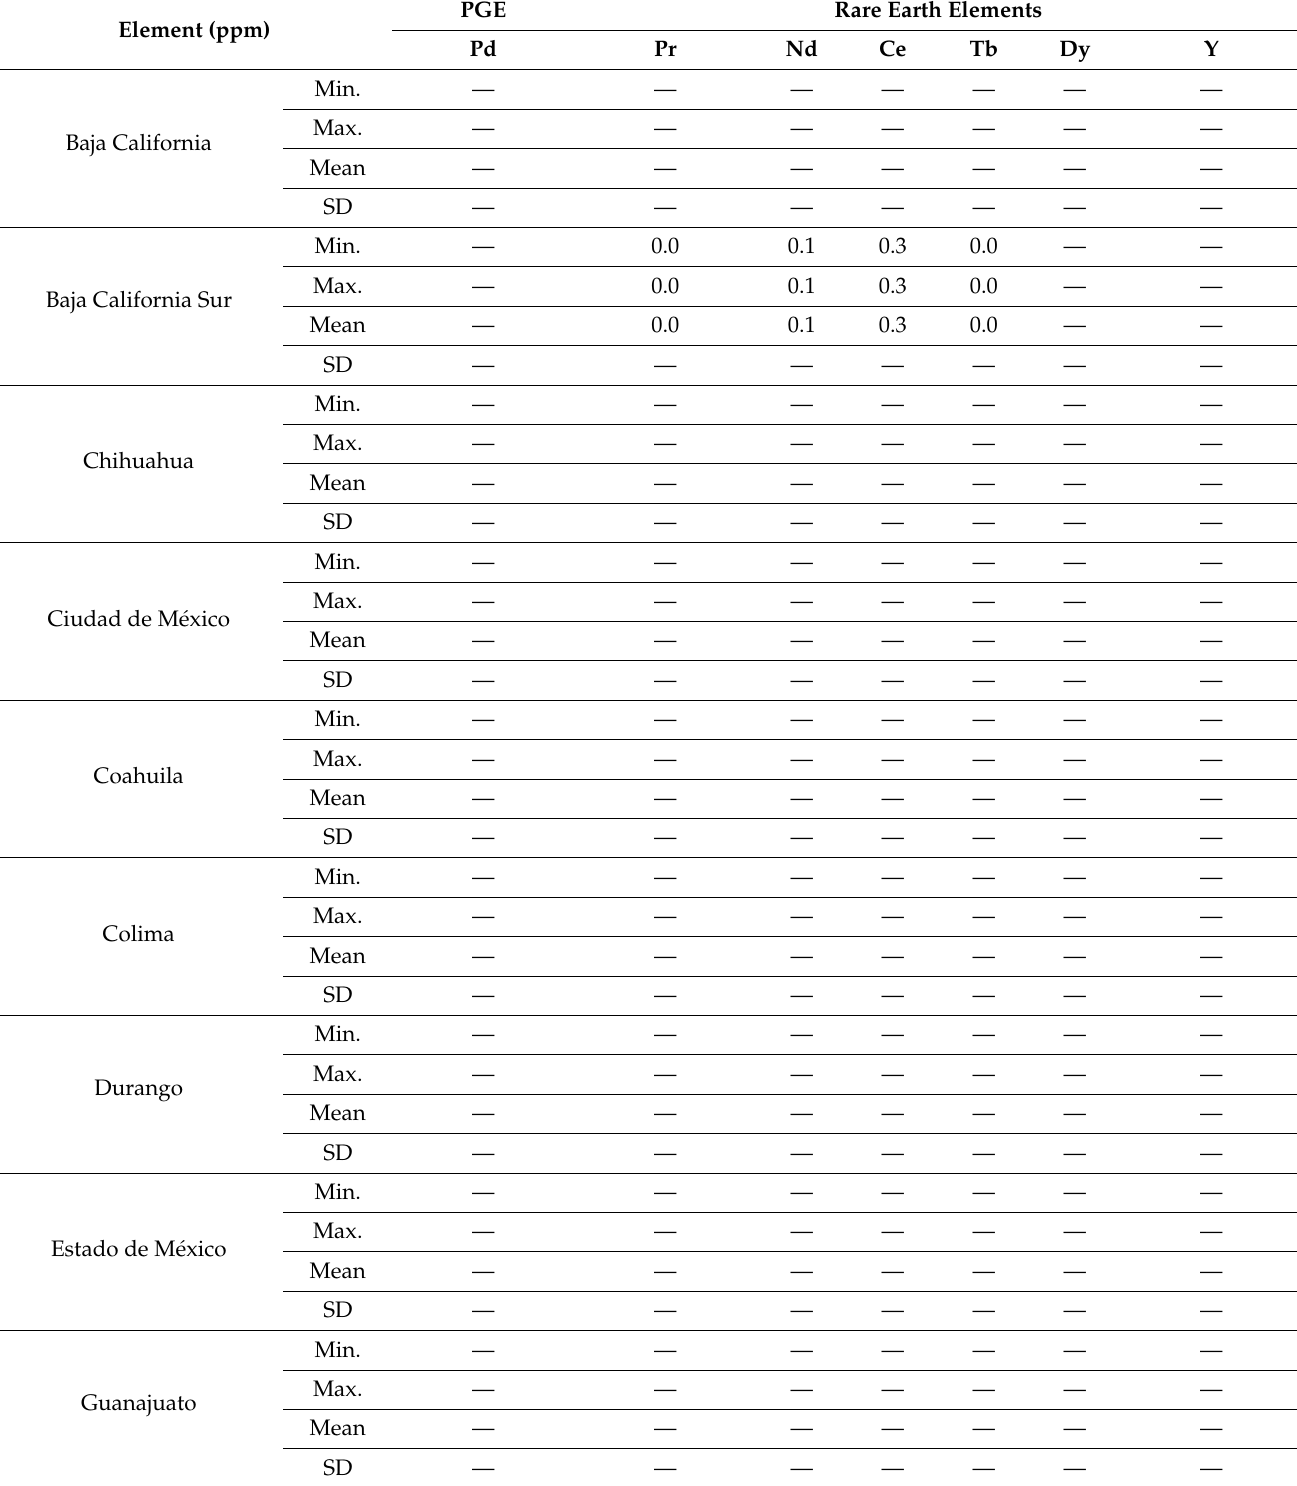
Table 3. Summary statistics of the elements classified as critical or with high economic relevance in each state from the Mexican data used in this study. Highlighted figures indicate a concentration above crustal abundance. PGE: Platinum Group Elements; SD: standard deviation; Min: minimum value; Max: maximum